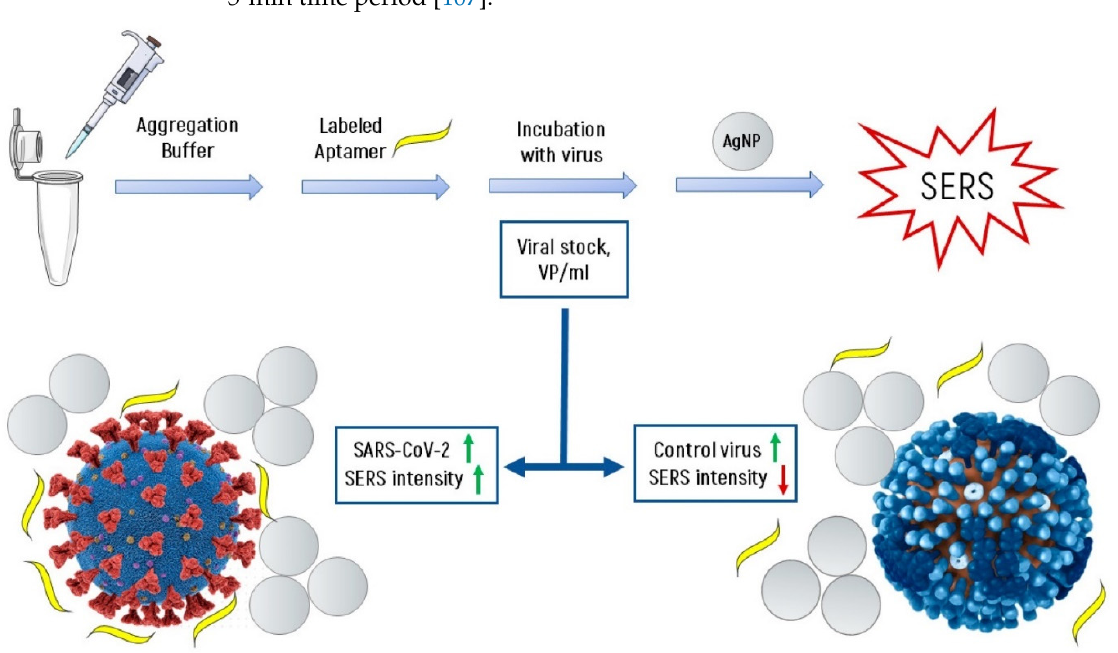
Figure 15. The scheme of the experiment and the formation of the SERS signal with an RBD-1C